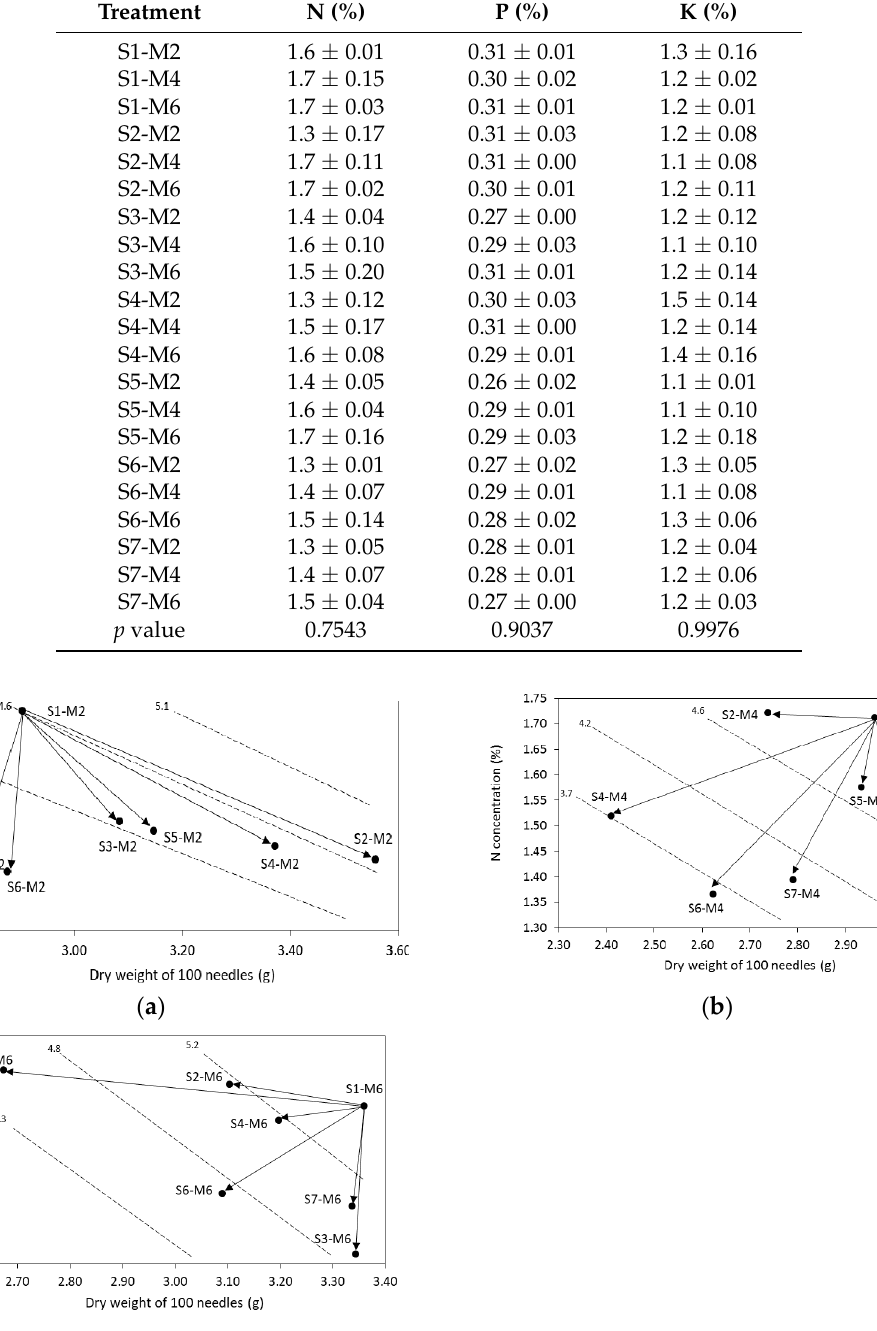
Table 4. Means of N, P and K concentrations in foliage of Pinus engelmannii .